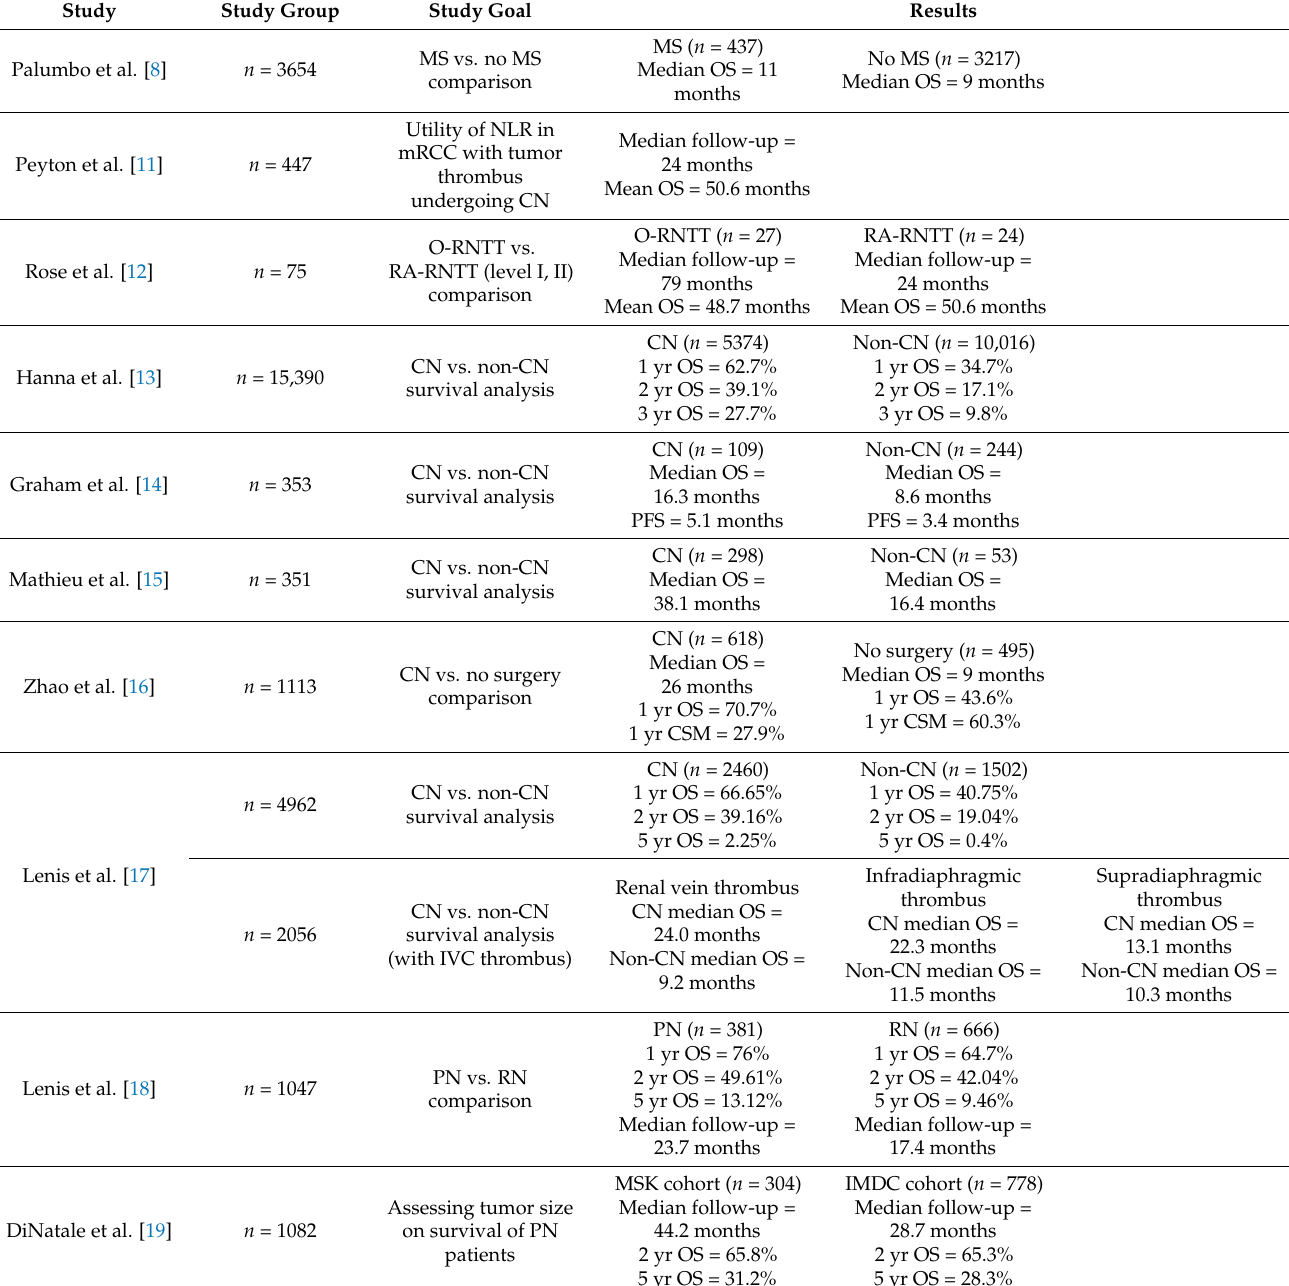
Table 1. Comparison of results for surgical management of